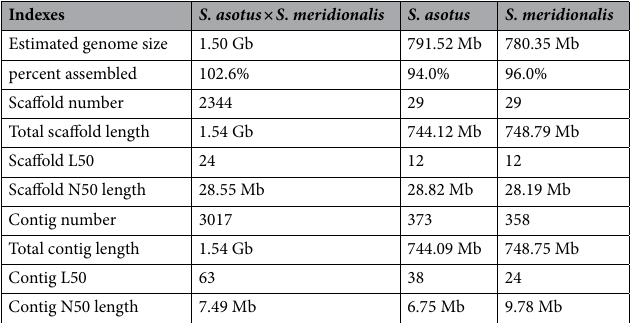
Table 1. Summary of indexes of the de novo assembly of the S. asotus × S. meridionalis hybrid